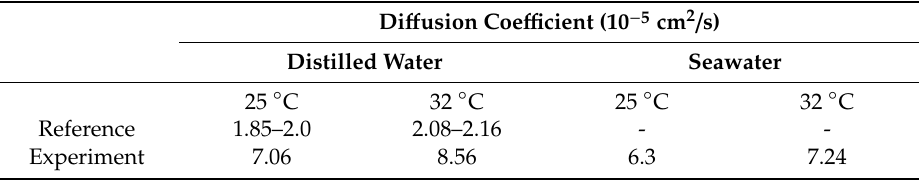
Table 6. Comparison of CO 2 di ff usion coe ffi cients by